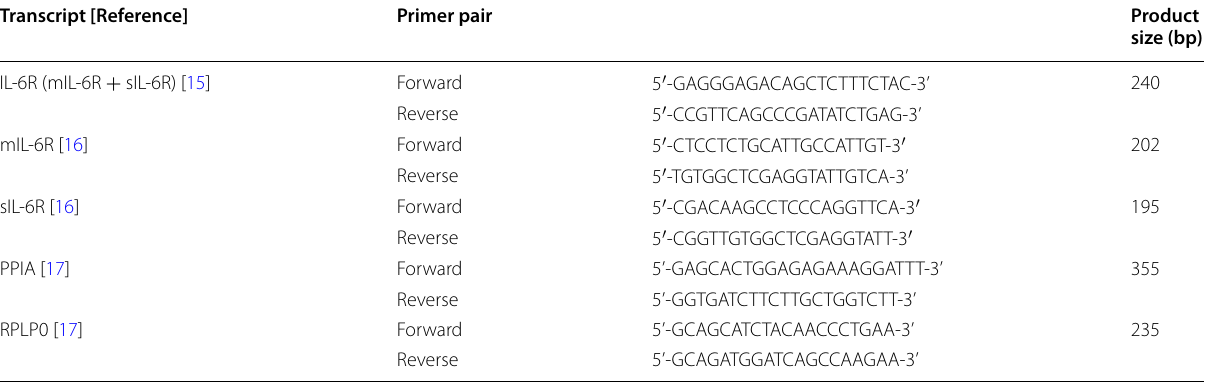
Table 1 Primer pairs and product sizes for gene